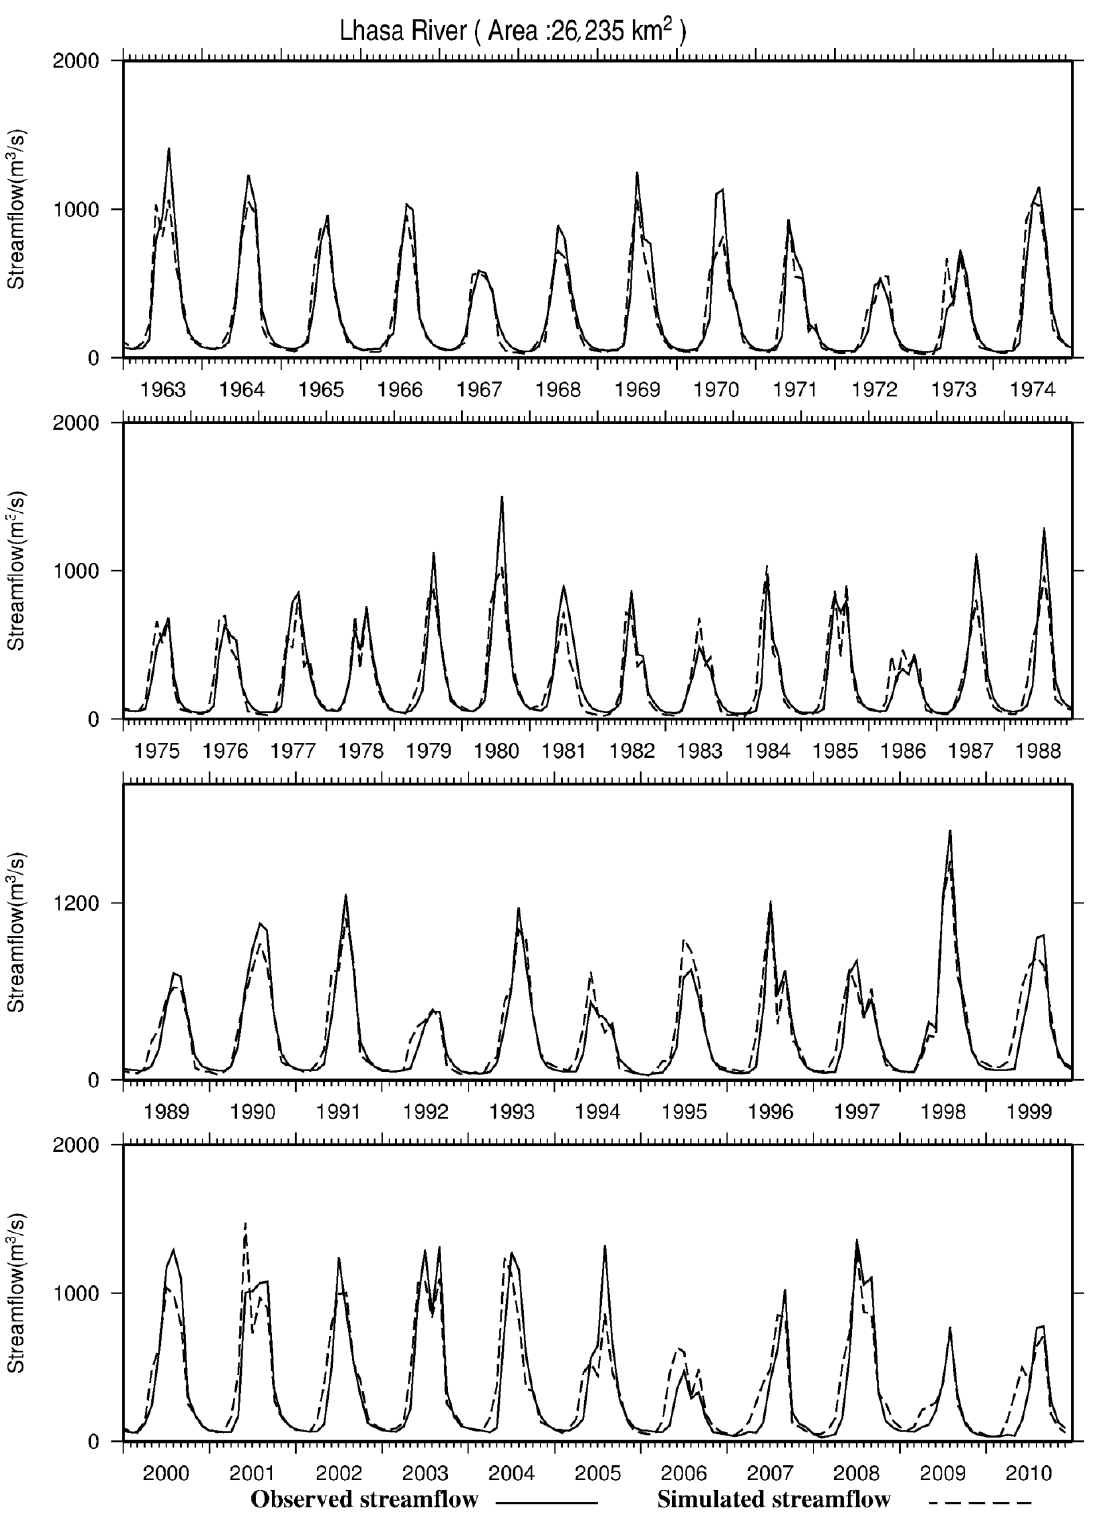
Figure 2. Simulated and observed monthly runoff for the period 1963–2010 in the Lhasa River Basin. 1963–1990 and 1991–2010 are the calibration and validation periods, respectively.